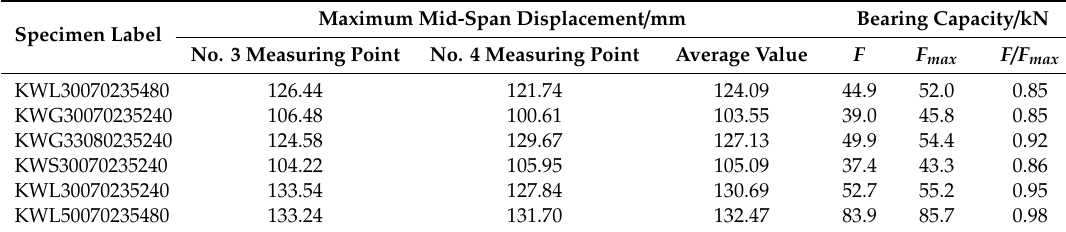
Table 3. Load test results.